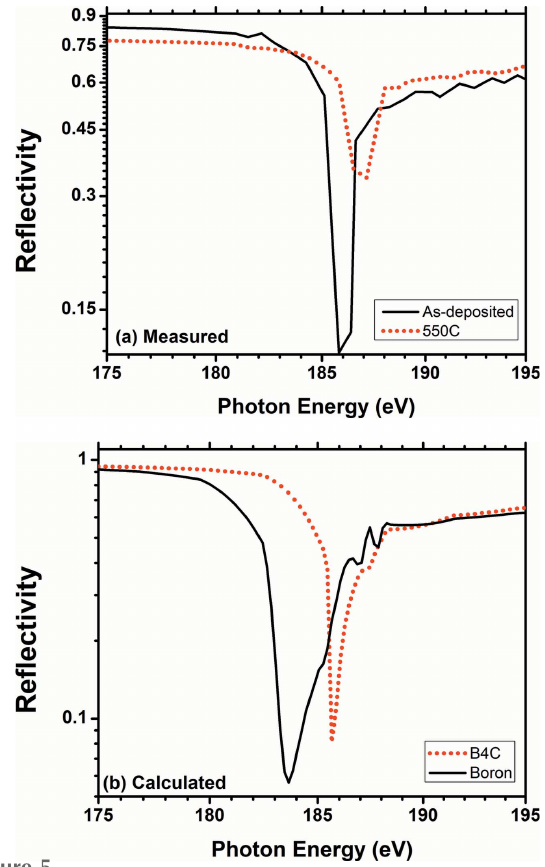
Figure 5 ( a ) Measured energy-dependent soft X-ray reflectivity of the boron carbide/Cr bilayer at 1.5 (cid:2) grazing-incidence angle for the as-deposited and 550 (cid:2) C annealed sample. ( b ) The calculated reflectivity of stoichio- metric B 4 C and boron is